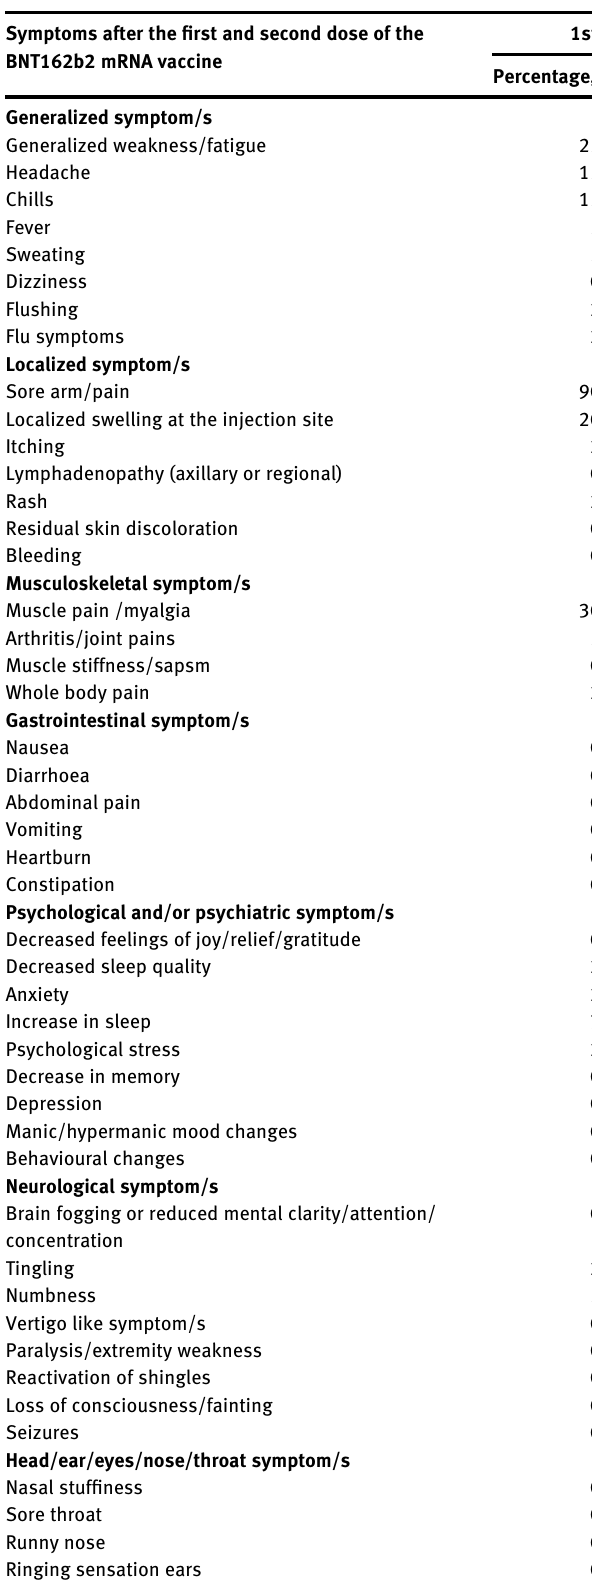
Table  : EventratesofsideeffectsafterthethirddosesoftheBNT  b  vaccine.Theresultsfor fi rstandsecondvaccinations[  ]wereshown as a